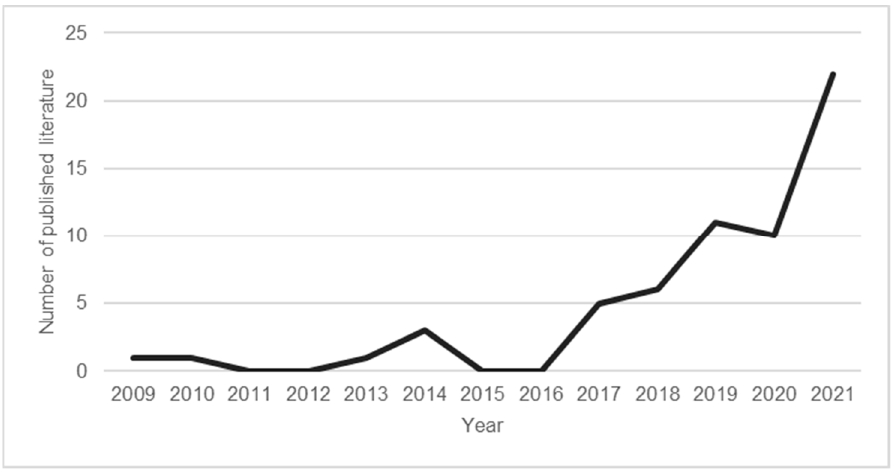
Figure 3. Publications in the CLD between 2009 and 2021. Table 2. Top ten cited papers from the CLD.